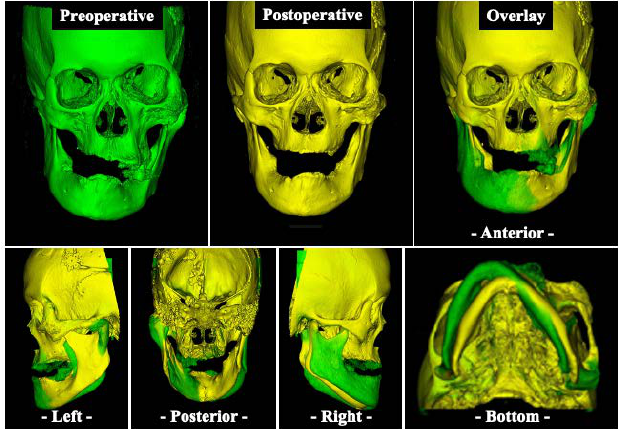
Figure 6. Postoperative clinical features. ( A ): Postoperative facial image. Improvement in facial sym- metry is noted. ( B ): Prosthodontist adjusted the denture to achieve a stable jaw position.